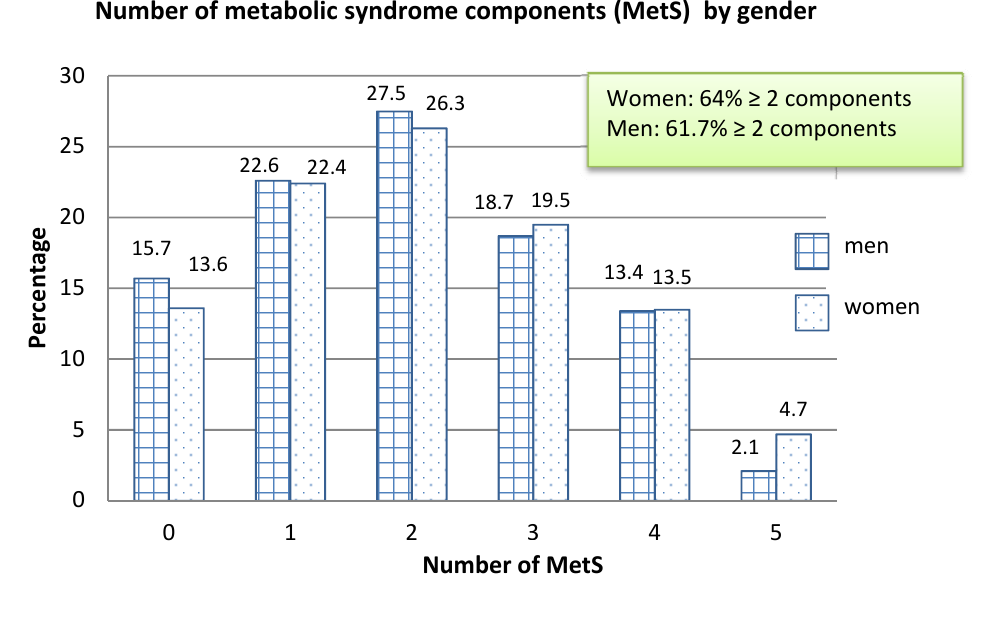
Table 2. Unadjusted and age-specific prevalence of metabolic syndrome in Kuwaiti